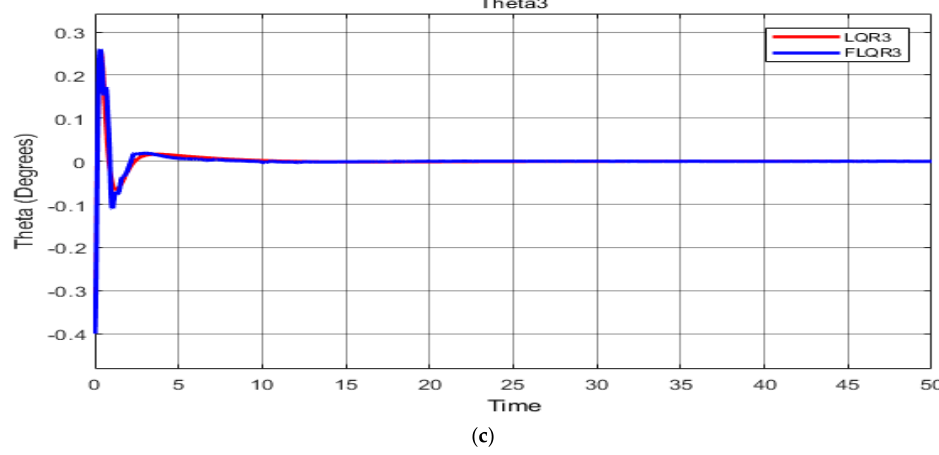
Figure 15. ( a ) The system response for the first link of Robogymnast in Case 5 (T1); ( b ) The system response for the 2nd link of Robogymnast in Case 5 (T2); ( c ) The system response for the lower link of Robogymnast in Case 5 (T3).